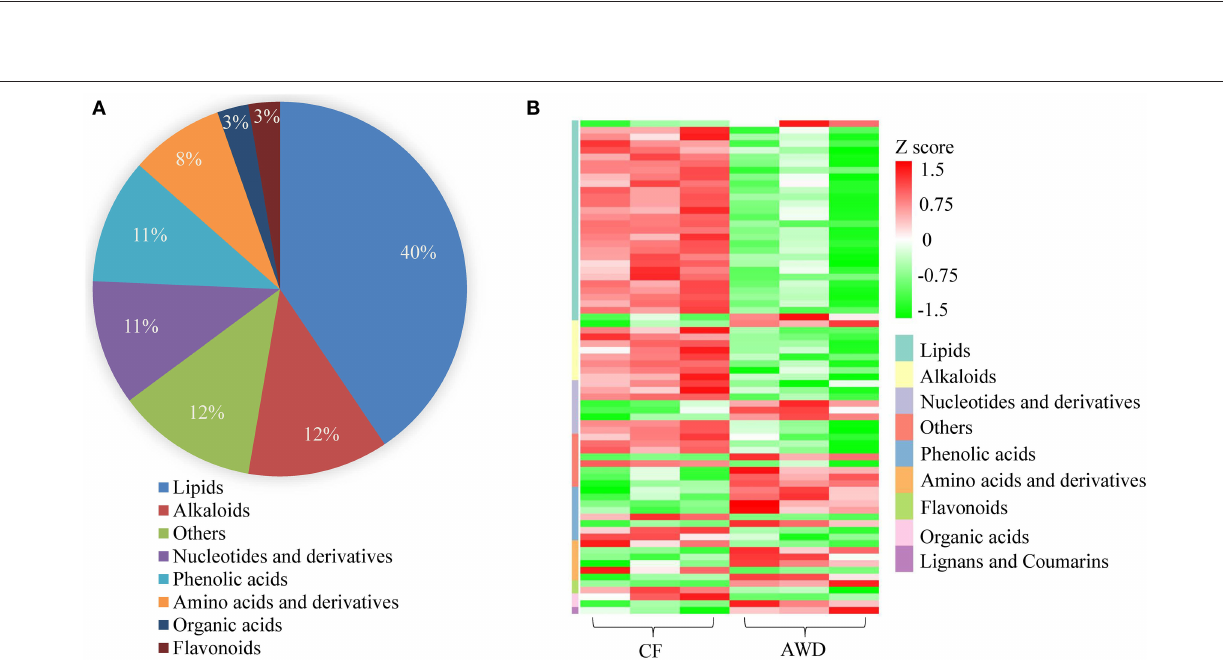
Frontiers in Plant Science |